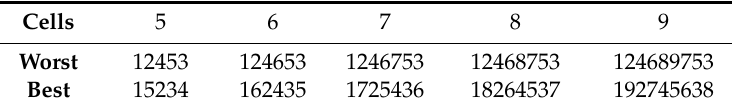
Table 2. Extreme DC Source Switching Sequences.